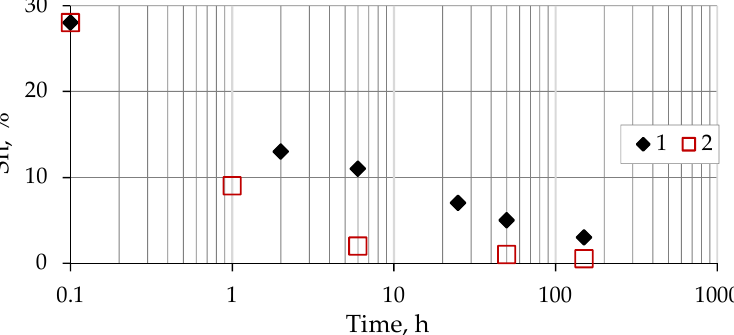
Figure 6. Time-dependent changes in the methane hydrate ( S h ) saturation of sand 1 with 14% of kaolinite clay (W = 14%) after the pressure dropped to 0.1 MPa: not cooled (1) and cooled (2) in liquid N 2 .